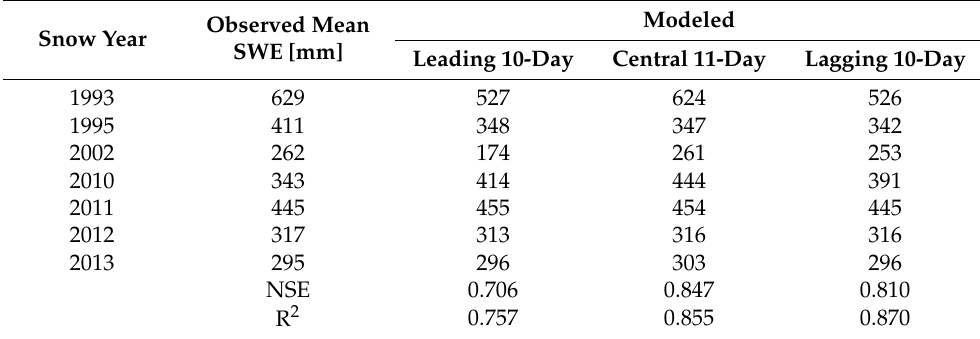
Table A3. Comparison of breakpoint prediction values of mean SWE for slope difference threshold of